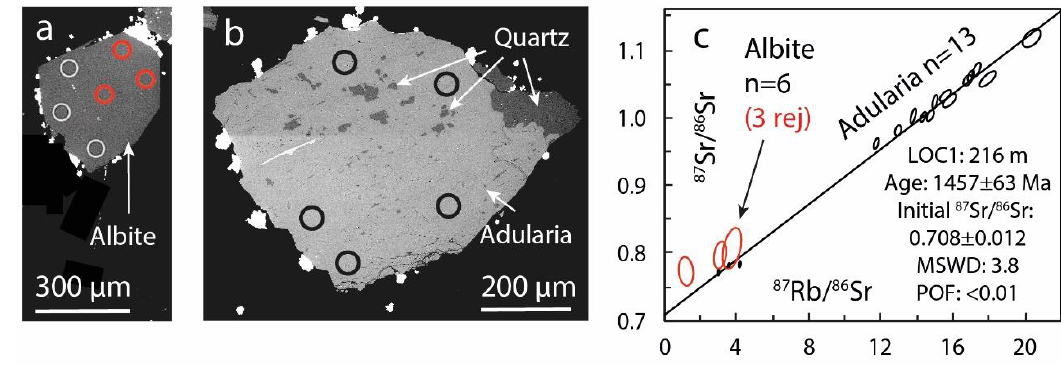
Figure A1. In situ Rb-Sr dating results of the 216 m sample with ( a ) albite spots as white circles, rejected albite spots as red circles, ( b ) adularia spots in one of three grains as black circles on BSE images and ( c ) the isochron diagram and the resulting data.